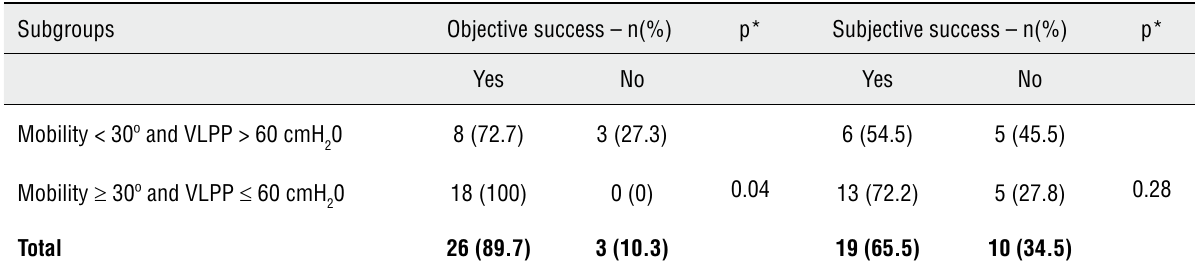
Table 3 - Comparison between specific subgroups. Subgroups